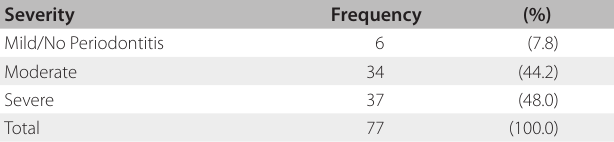
Table 5. Distribution of periodontal disease severity in case group Severity